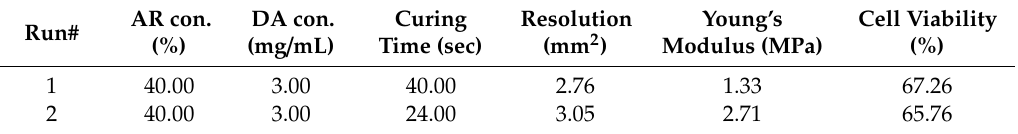
Figure 3. The main effect of ( A ) amine-based resin (AR) concentration and ( B ) dopamine (DA) concentration on the resolution. Table 2. Experimental factors (columns 2–4) and response variables (columns 5-7) of the 2 3 fractional factorial screening design (#1–#11).